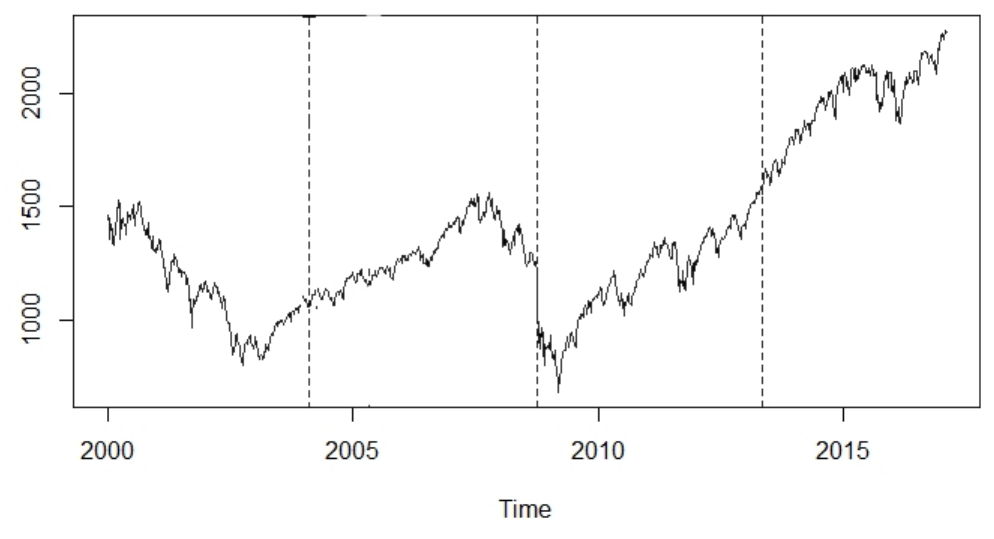
Figure 2. Structural breaks in the S&P 500 time series.